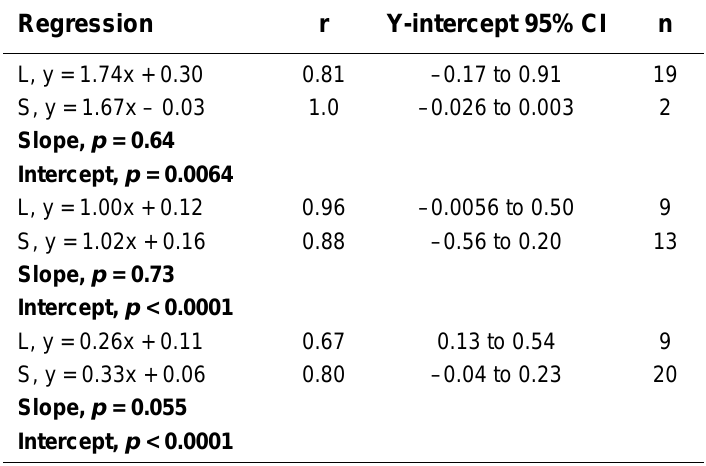
Reduction of the Whole Data Fan (n = 2 × 36) in Females in Fig. 4 to Three Groups of Data, Simvastatin (S) and Lovastatin (L)